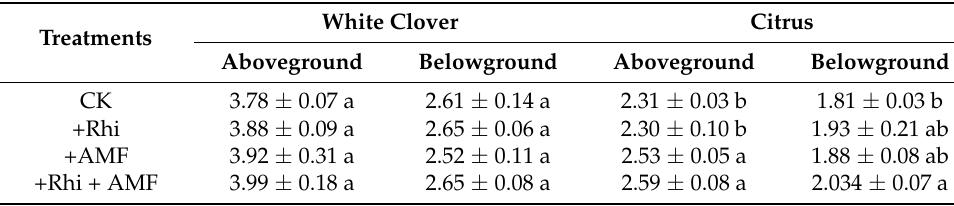
Table 3. N concentration (%) in various parts of white clover and citrus grown in pots.